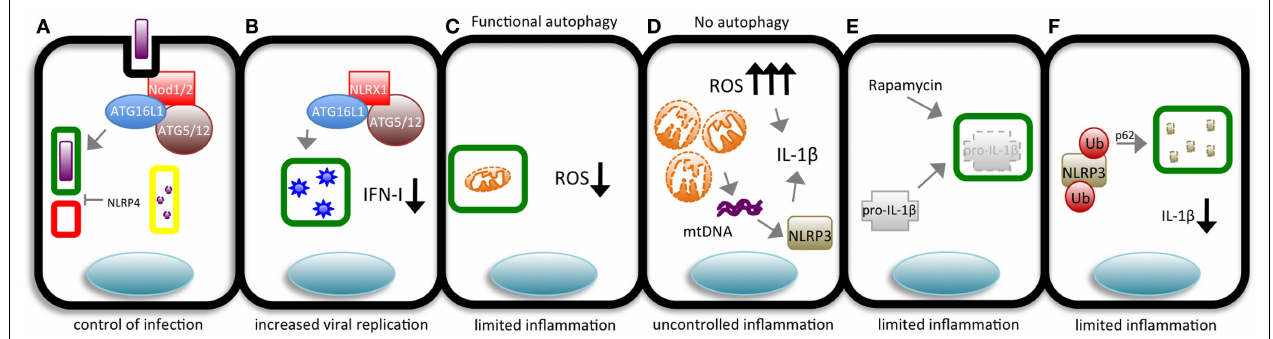
swollen mitochondria and high levels of ROS, leading to uncontrolled IL-1 β production. Alternatively, damaged mitochondria release mitochondrial DNA (mtDNA), which is sensed by NLRP3 that, together with ROS, induces the production of IL-1 β . (D) Inflammasome sensors are ubiquitinated and targeted to autophagosomes (green rectangles) for degradation, limiting the production of IL-1 β . (E) Pro-IL-1 β is targeted to autophagosomes (green rectangles) upon autophagy induction (by rapamycin) to limit the magnitude of inflammation. (F) NLRX1 associates with ATG16L1 and the ATG5/12 complex to induce the formation of autophagosomes (green rectangles) targetingVSV, which later fuse with lysosomes (red square), forming autolysosomes (yellow rectangles) in which the virus is